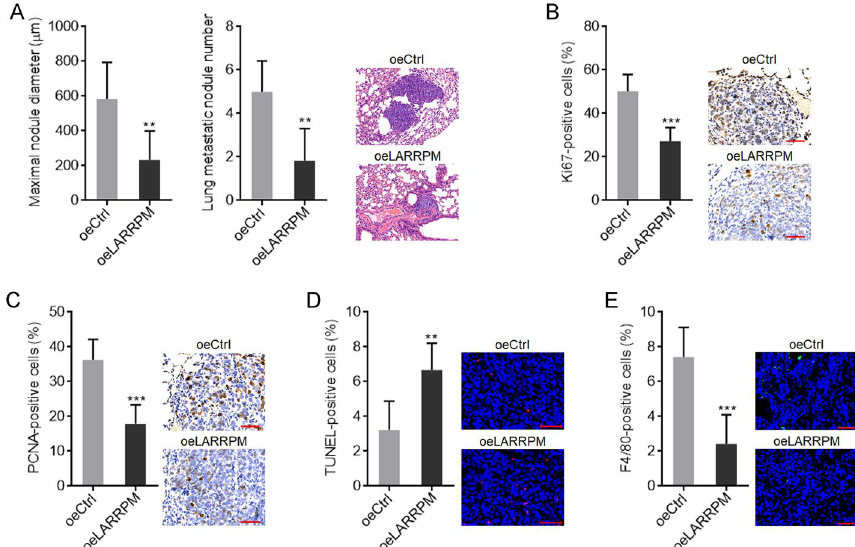
Fig. 3 LARRPM repressed LUAD development in vivo. a A549 cells with LARRPM stable overexpression or A549 control cells were injected into tail vein of nude mice. Six weeks later, lung metastatic nodules were detected using hematoxyln and eosin (HE) staining. b , c Immunohistohemistry (IHC) staining of the antigens Ki67 ( b ) and PCNA ( c ) in lung metastatic nodules formed by A549 cells with LARRPM stable overexpression or A549 control cells. Scale bar: 50 µm. d TUNEL assays using lung metastatic nodules formed by A549 cells with LARRPM stable overexpression or A549 control cells. Scale bar 50 µm. e Immunofluorescence (IF) staining = of F4/80 antigen in lung metastatic nodules formed by A549 cells with LARRPM stable overexpression or A549 control cells control. Scale bar: 50 µm. Results are shown as the mean SD based on n 6 mice in each ± = group. Asterisks indicate a significant difference at ** P < 0.01, *** P < 0.001 by the Student’s t